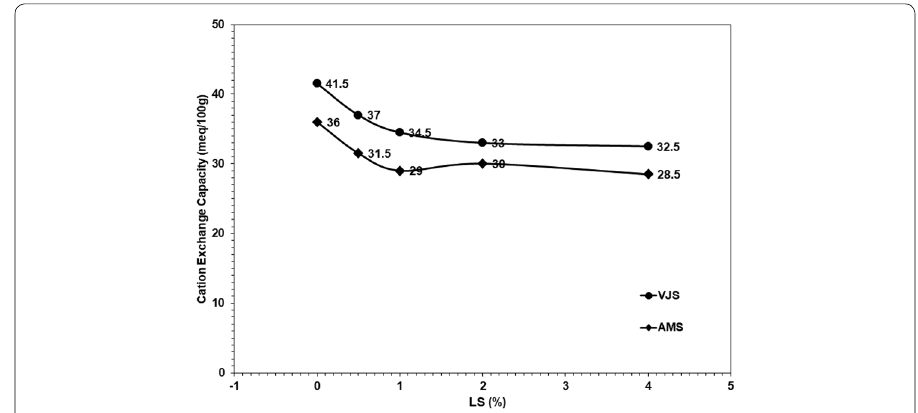
Fig. 2 Cation exchange capacity of lignosulfonate treated